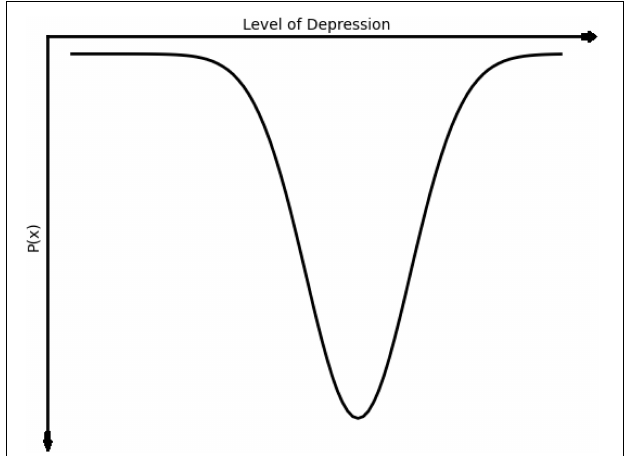
FIGURE 4 | The stochastic change process (Tschacher and Haken, 2019), which involves a shift from a narrower, deeper basin of attraction to a wider distribution of system states, such as a wider range of emotional states, in either positive or negative directions.